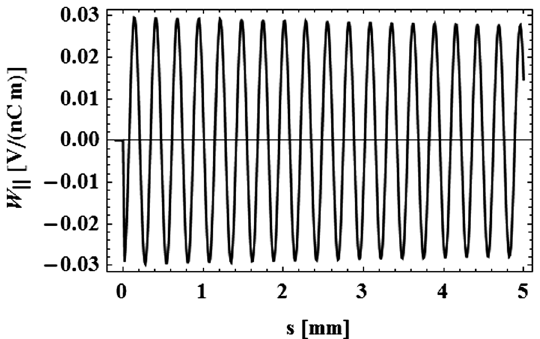
FIG. 15. Longitudinal monopole wake function of a perfectly conducting waveguide with a thin inner dielectric layer; a